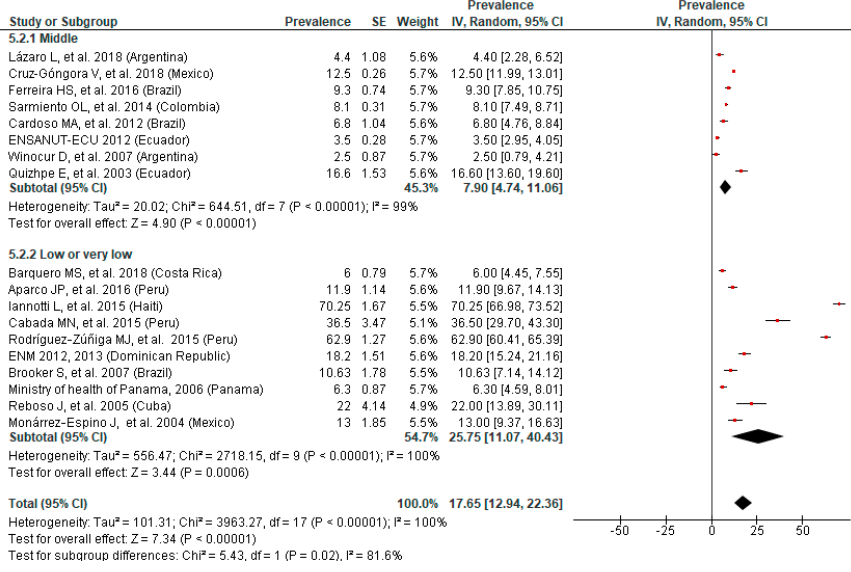
Figure 6. Prevalence of anemia in school-age children by socioeconomic status.